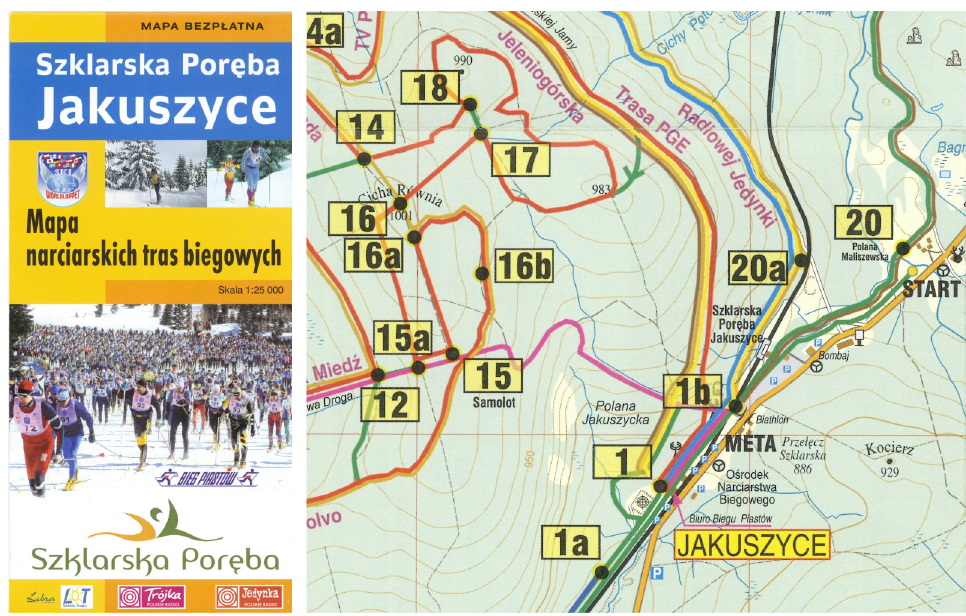
Fig. 2. Szklarska Poręba Jakuszyce. Mapa narciarskich tras biegowych (Szklarska Poręba Jakuszce. Map of ski runner’s tracks) 1:25 000 . Wydawnictwo